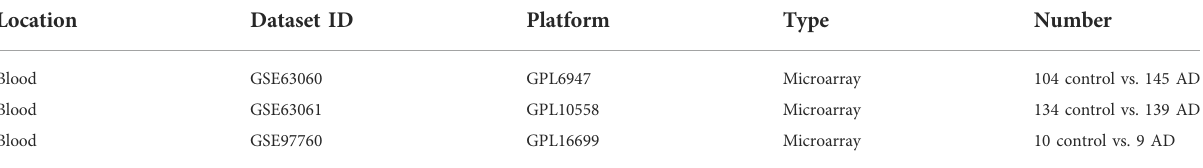
TABLE 1 Dataset information from the GEO